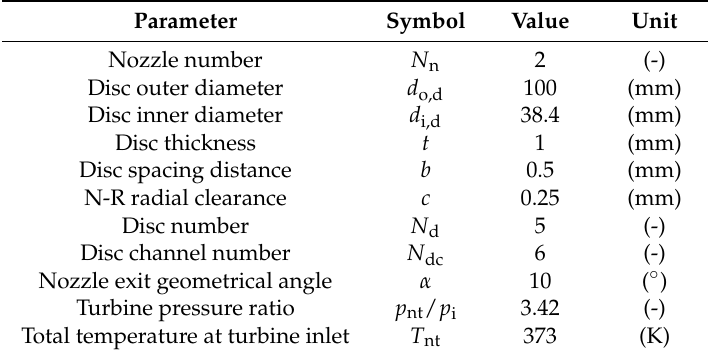
Table 2. Geometrical and operational parameters